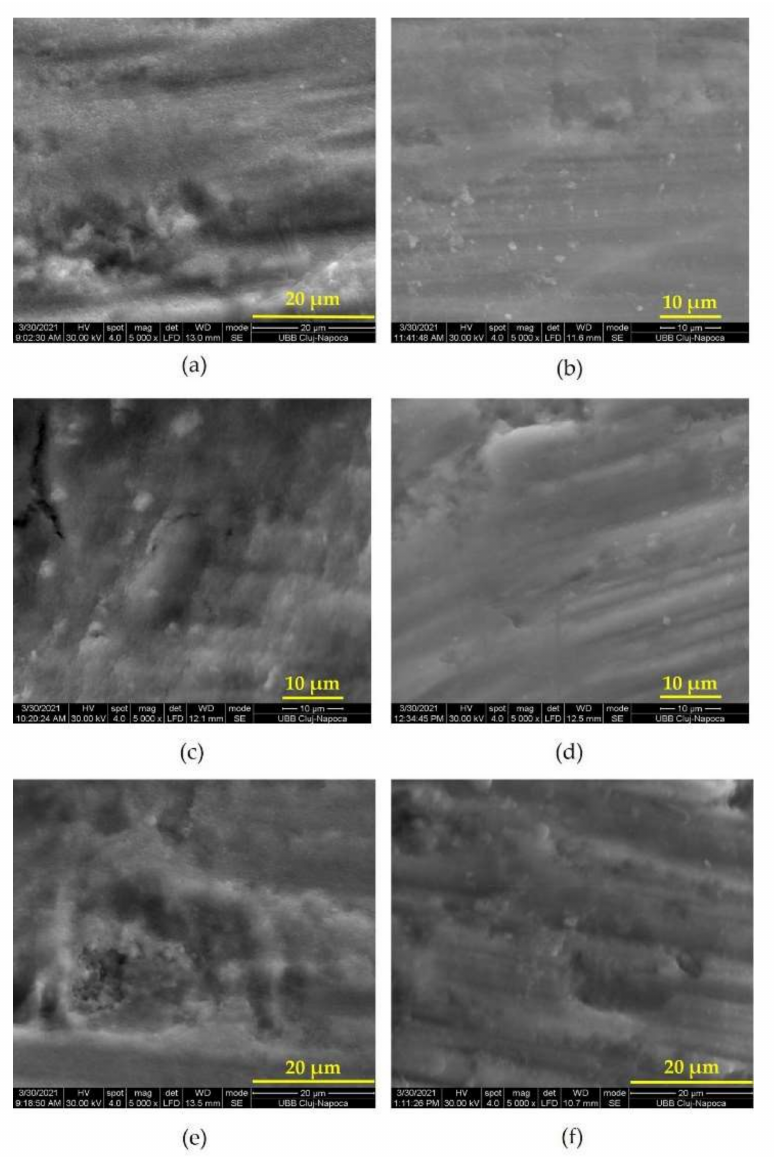
Figure 2. SEM images of contaminated teeth surface before and after PDT: ( a ) expansive colonization by S. mutans , biofilm covering entire veneer preparation; ( b ) SEM view after PDT on veneer prepara- tion surface; ( c ) S. mutans biofilm on crown preparation; ( d ) crown preparation surface after PDT; ( e ) SEM image of S. mutans biofilm on inlay preparation; ( f ) inlay preparation surface after